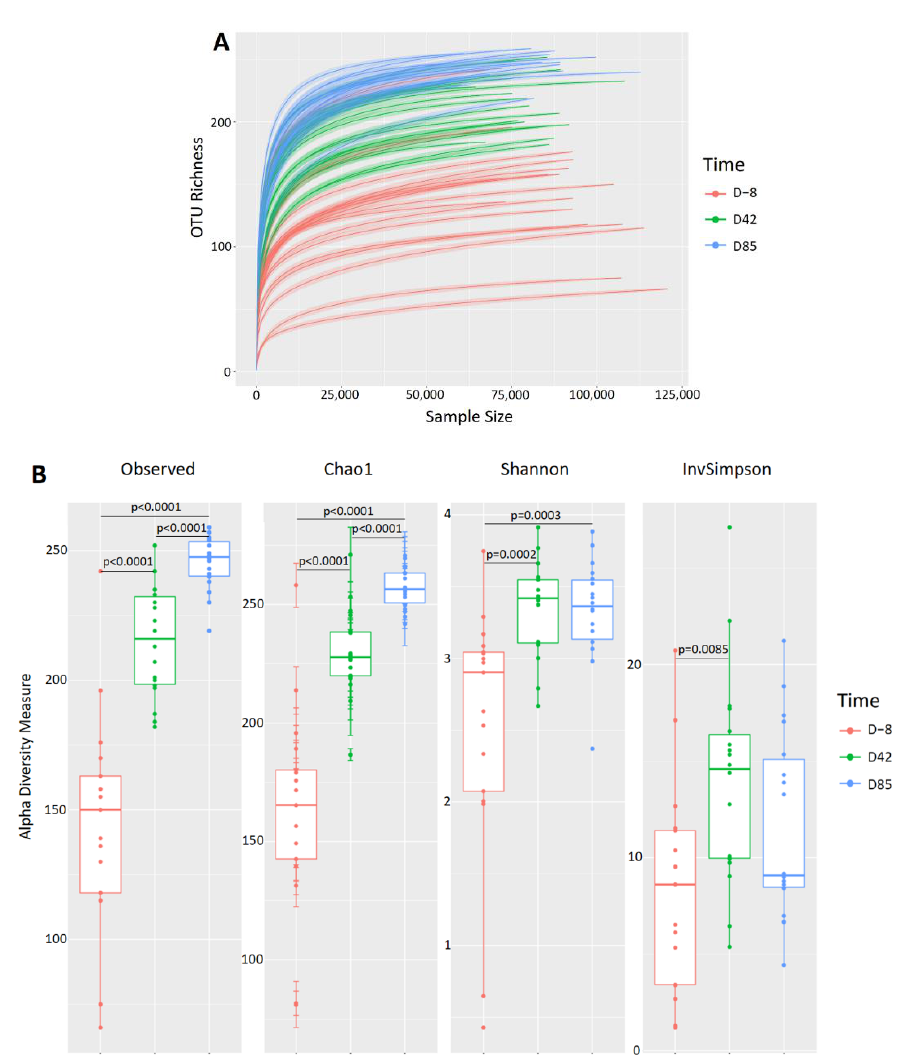
Figure 4. ( A ) Rarefaction curves, ( B ) alpha diversity measures. p -values were determined using the Mann–Whitney test.